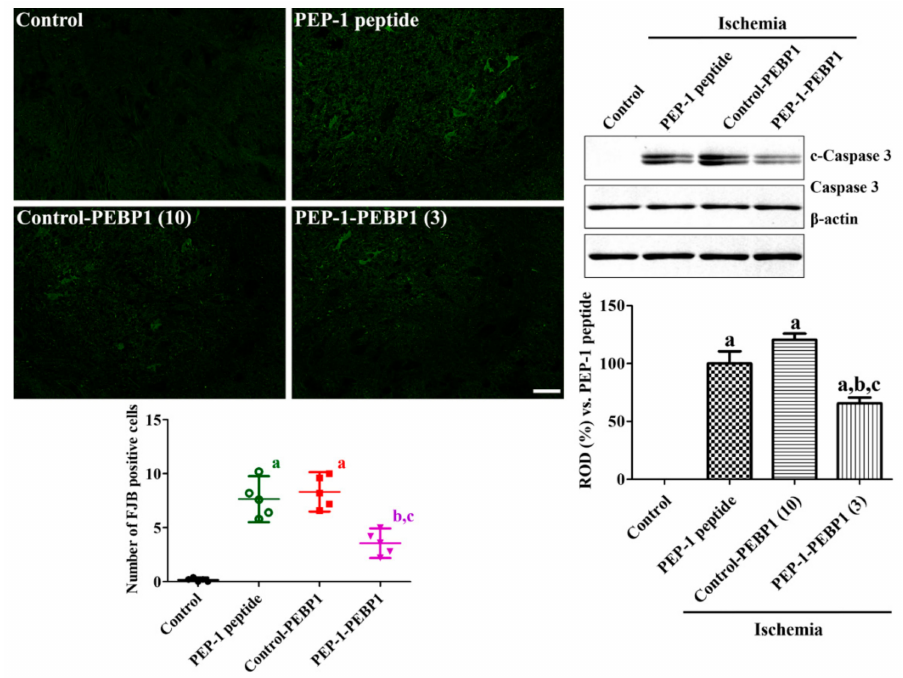
Figure 5. E ff ect of Control-PEBP1 and PEP-1-PEBP1 protein on cell death and caspase 3 expression in the rabbit spinal cord against ischemic damage. Fluoro-Jade B (FJB) staining is conducted to